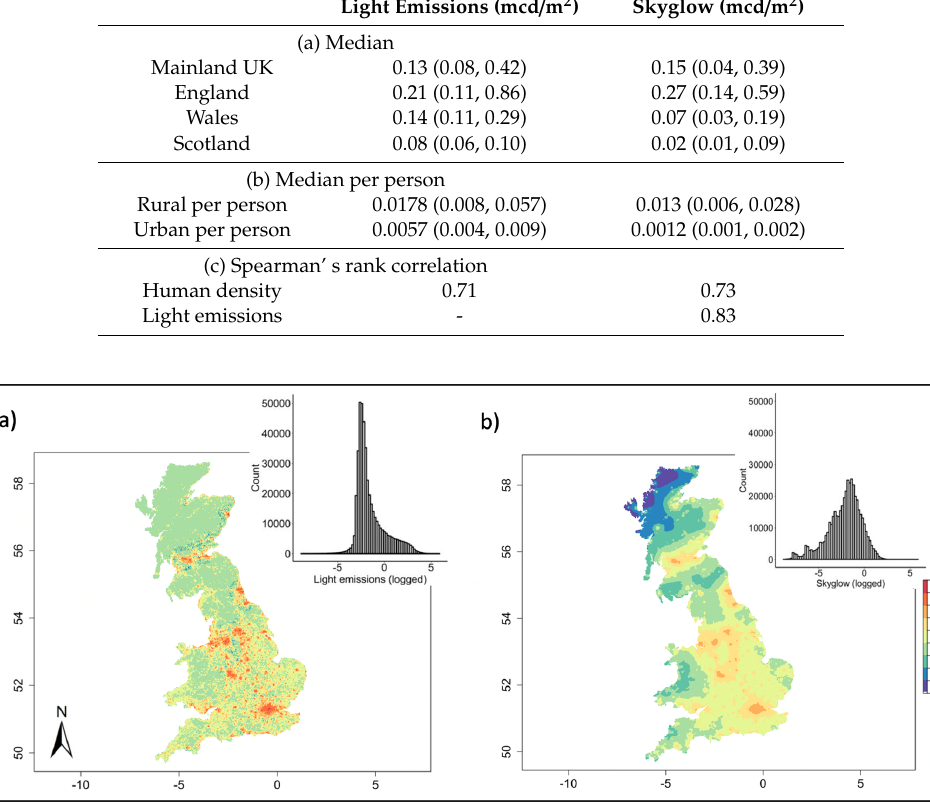
Figure 2. Spatial variation in ( a ) light emissions (logged) and ( b ) skyglow (logged) on mainland Britain. Histograms show the number of pixels of different intensities in bands of 0.2. Projected on the British National Grid, with a resolution of 544 m by 927 m.